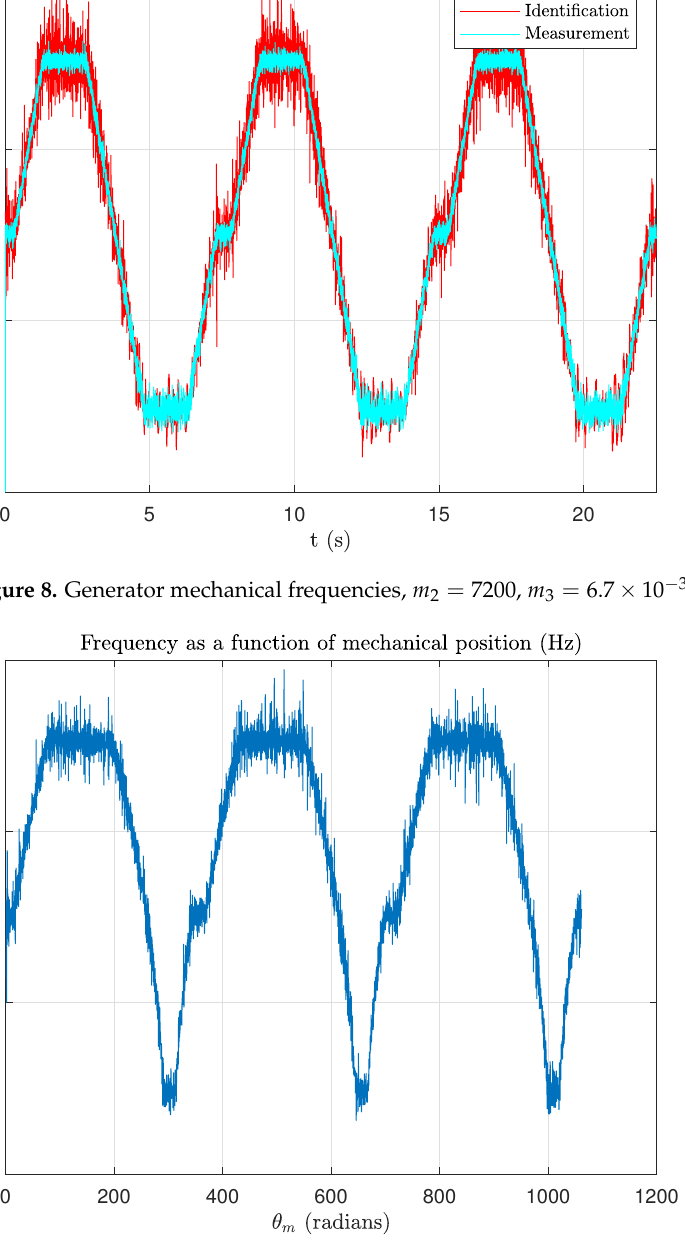
Figure 9. Frequency as a function of mechanical